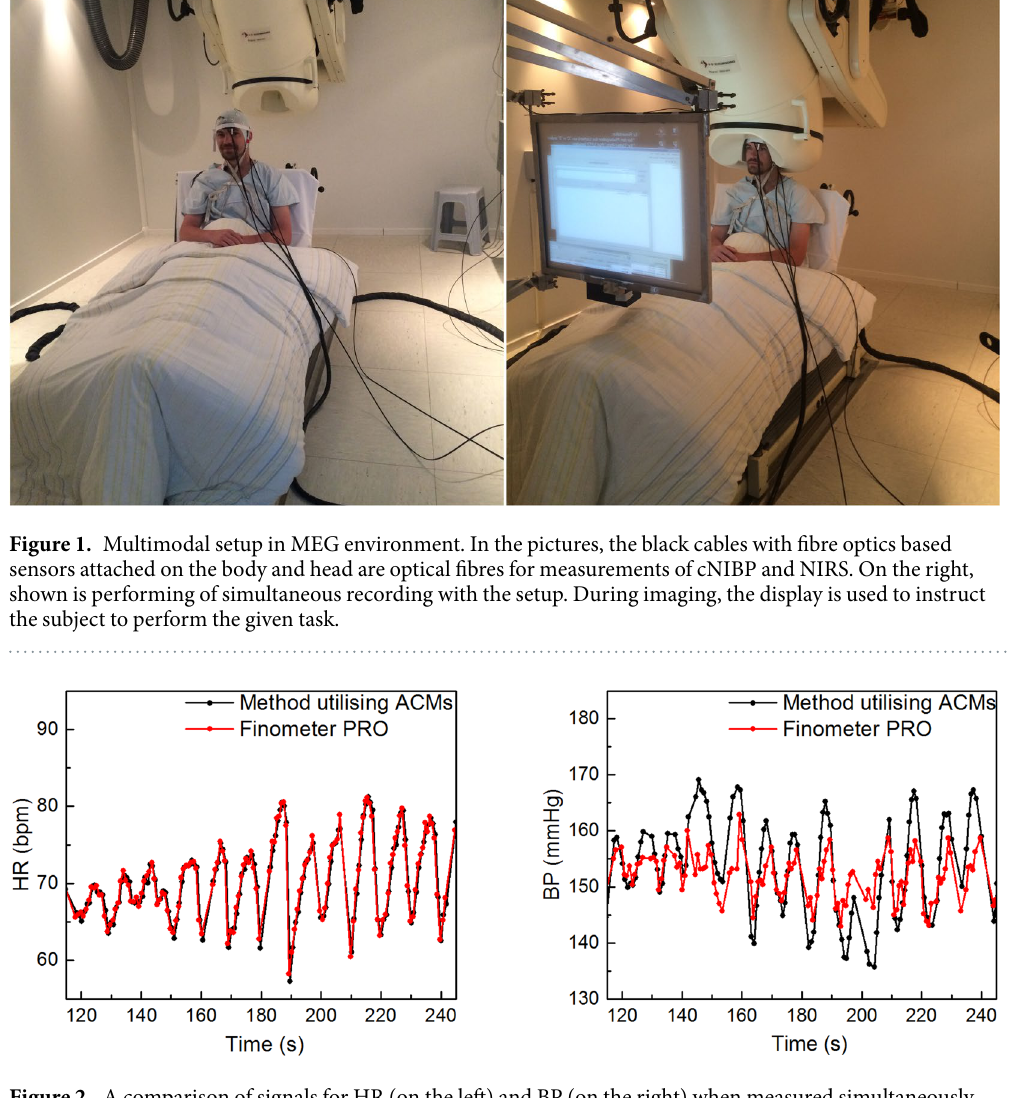
Figure 2. A comparison of signals for HR (on the left) and BP (on the right) when measured simultaneously with Finapres and with the developed MEG compatible cNIBP device, based on PTT measured with optical ACMs. The correlation for BP signals is r > 0.7 and for HRs r > 0.95. The BP estimation from the PTT is based on the formula presented in publication by Gesche et al . 27